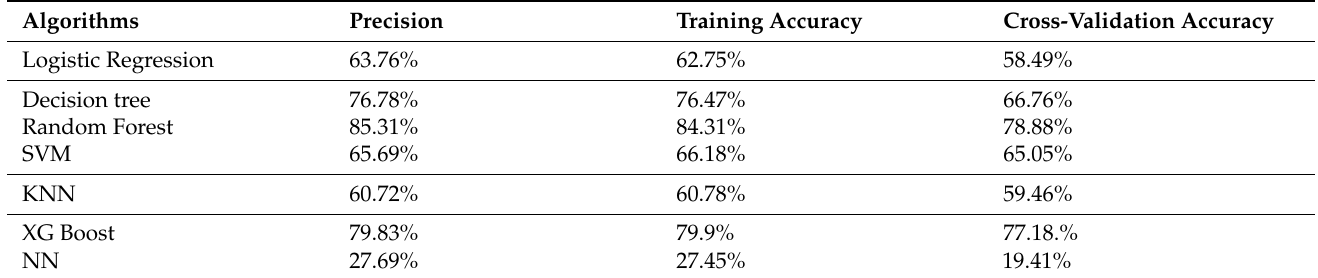
Table 3. Classifier’s performance comparison for random